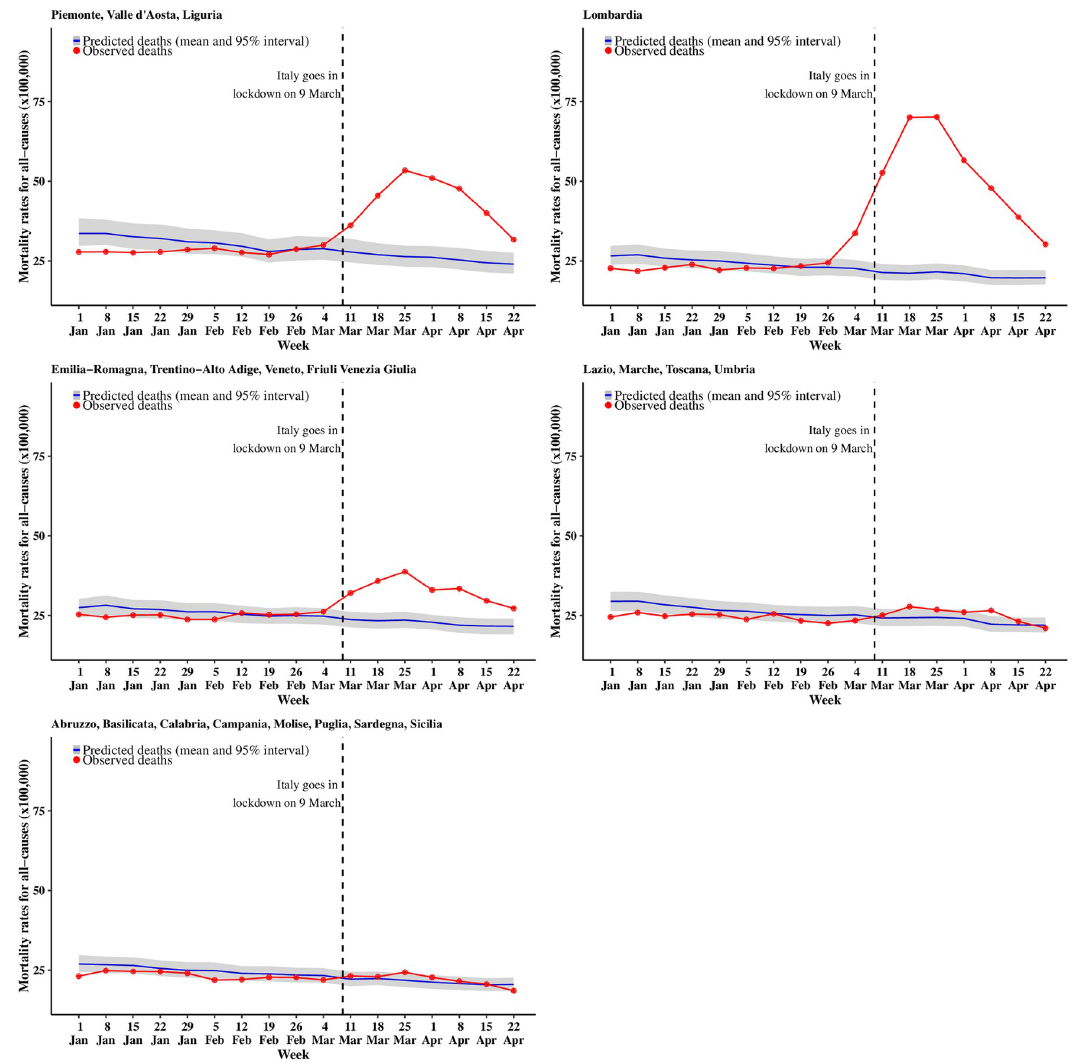
Fig 2. Trend for all cause mortality (females). The blue curve shows the posterior mean predicted from the 2016–2019 model, while the gray ribbon describes the posterior 95% interval; the observed number of deaths for 2020 are in red.